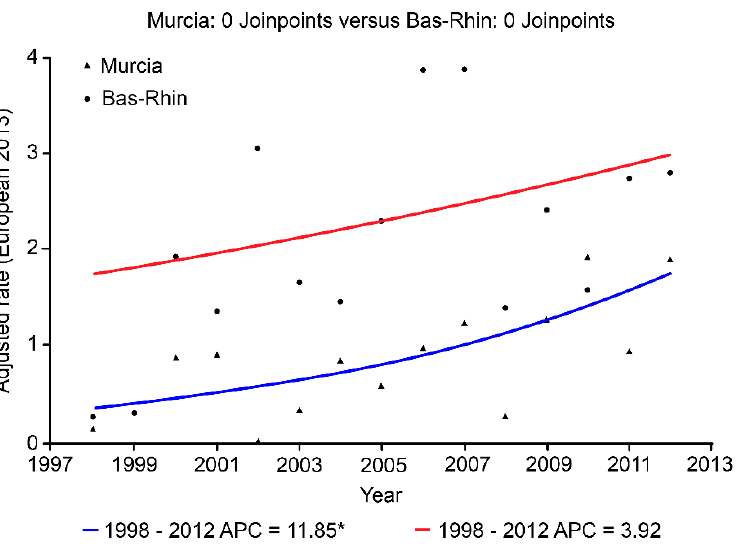
Figure 3. Joinpoint analysis of age ‐ adjusted incidence rates (per 100,000 py) of type II endometrial carcinoma in the Region of Murcia and the Bas-Rhin area, 1998–2012 period. APC: Annual Percent Change. * p < 0.01